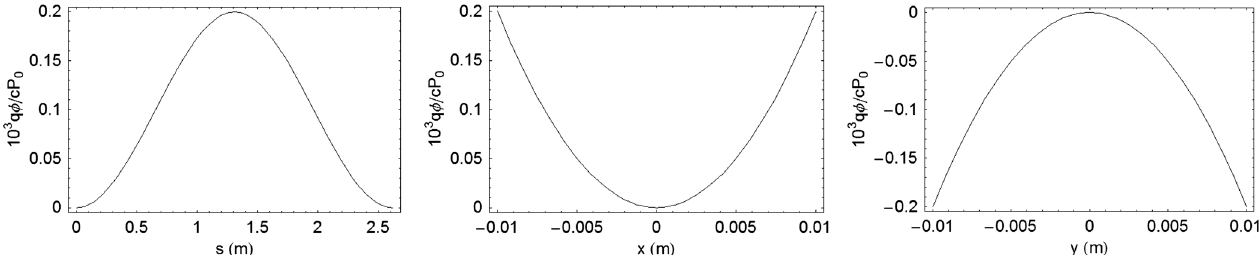
FIG. 6. Variation of the electrostatic potential (95) in a curvilinear quadrupole, as a function of the coordinates s (left-hand plot, for x ¼ 10 mm and y ¼ 0 ), x (middle plot, for y ¼ 0 and s ¼ π